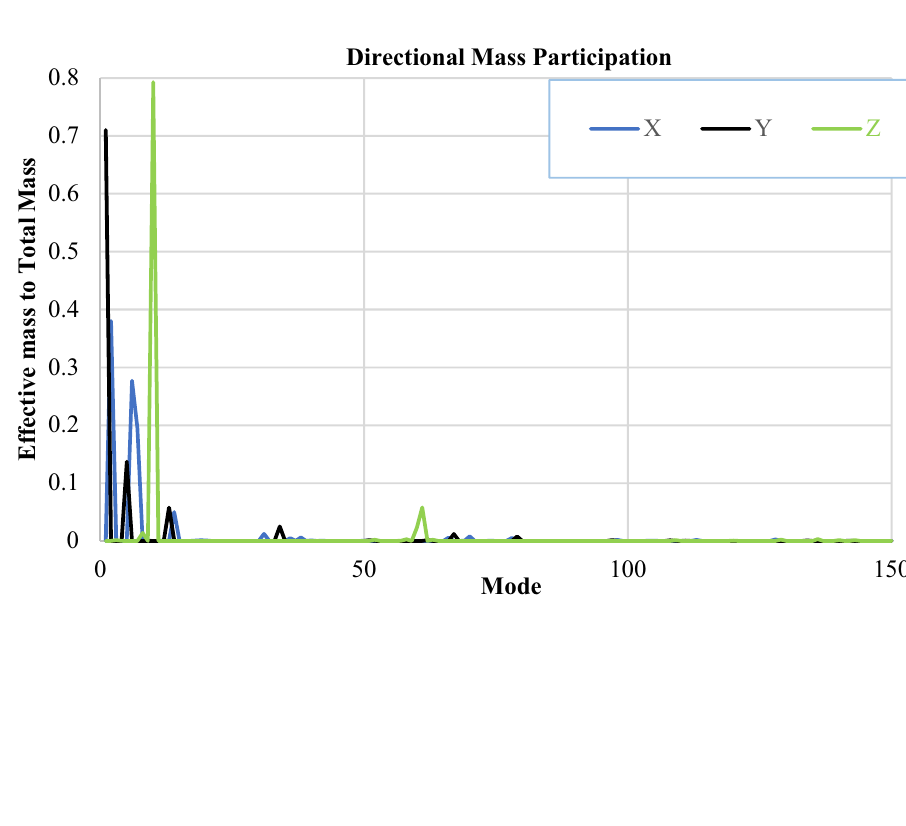
Fig. 6 Participation of effective modal